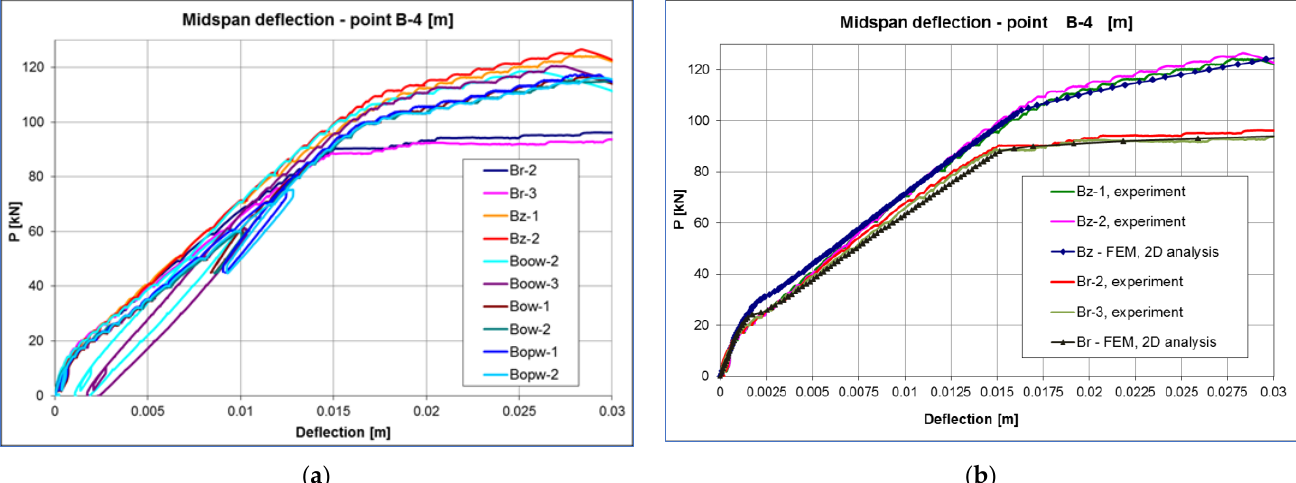
Figure 5. ( a ) Deflections of the point in the middle of beam span (point B-4 according to Figure 3) obtained in experiments. ( b ) Comparison of experiment and FEA results — point B-4 deflection for RC beam (Br) and beam with CFRP strip (Bz).